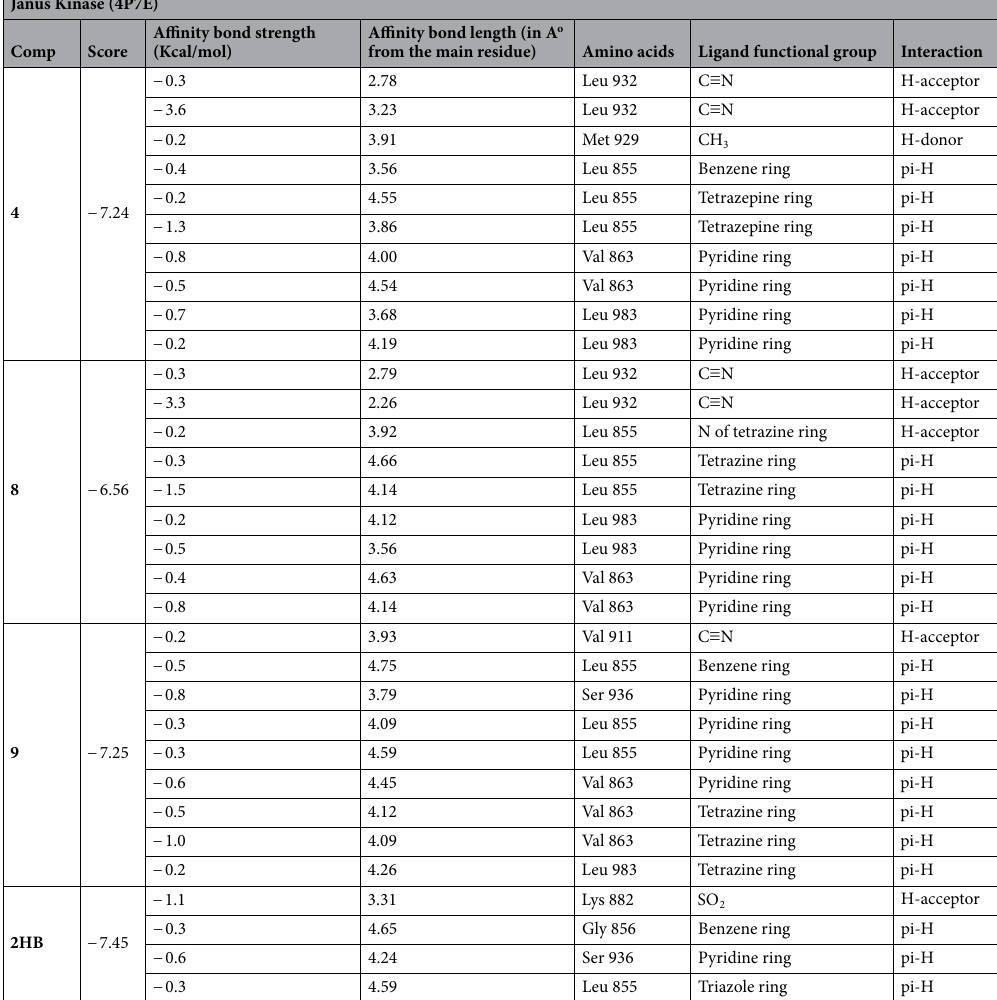
Table 2. Docking results of compounds 4 , 8 , 9, and 2HB ligand inside Janus Kinase Jak2 (PDB ID: 4P7E ) active